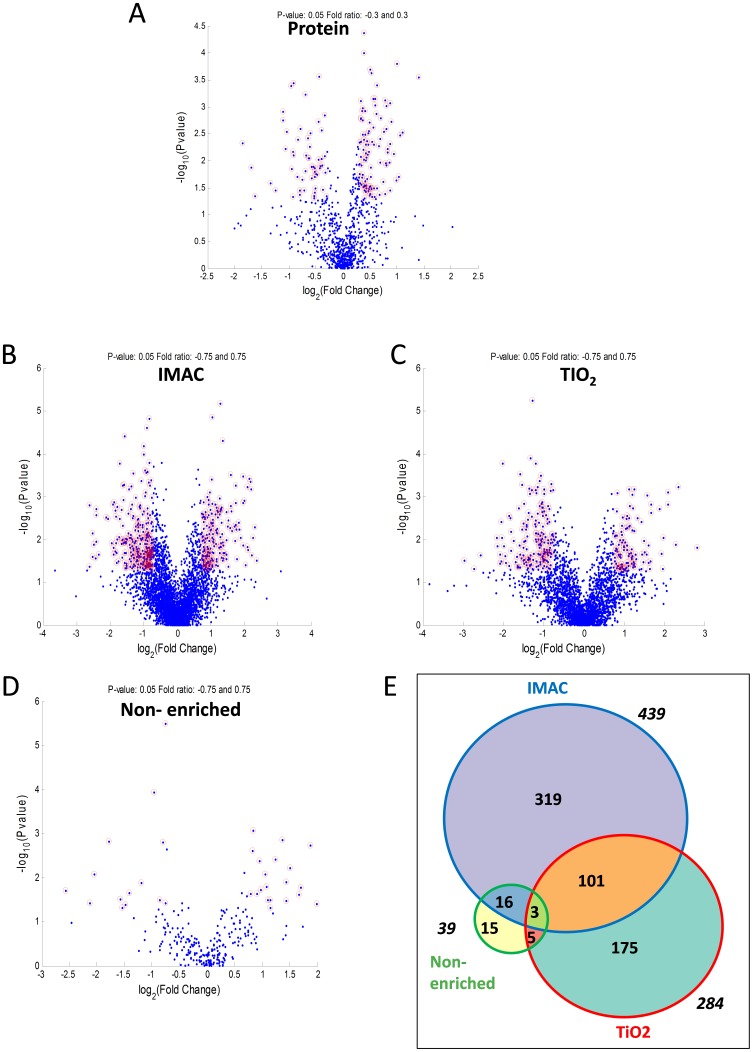
Number of significantly modulated proteins and phosphopeptides.Volcano plots showing −log10 P-values in relation to log2 T/NT ratios for; A: relative protein abundance (determined from median non-phosphopeptide log2 T/NT ratios), B: phosphopeptides measured in the IMAC, C: TiO2, D: and Non-enriched arm of the SysQuant workflow. Red circles point out significantly modulated proteins (log2 T/NT ratios ≥0.3 or ≤−0.3 and p-values ≤0.05) and phosphopeptides (log2 T/NT ratios ≥0.75 or ≤−0.75 and p-values ≤0.05). E: is a Venn diagram illustrating the distribution of the 635 phosphopeptides across the three arms of the workflow that were significantly modulated.